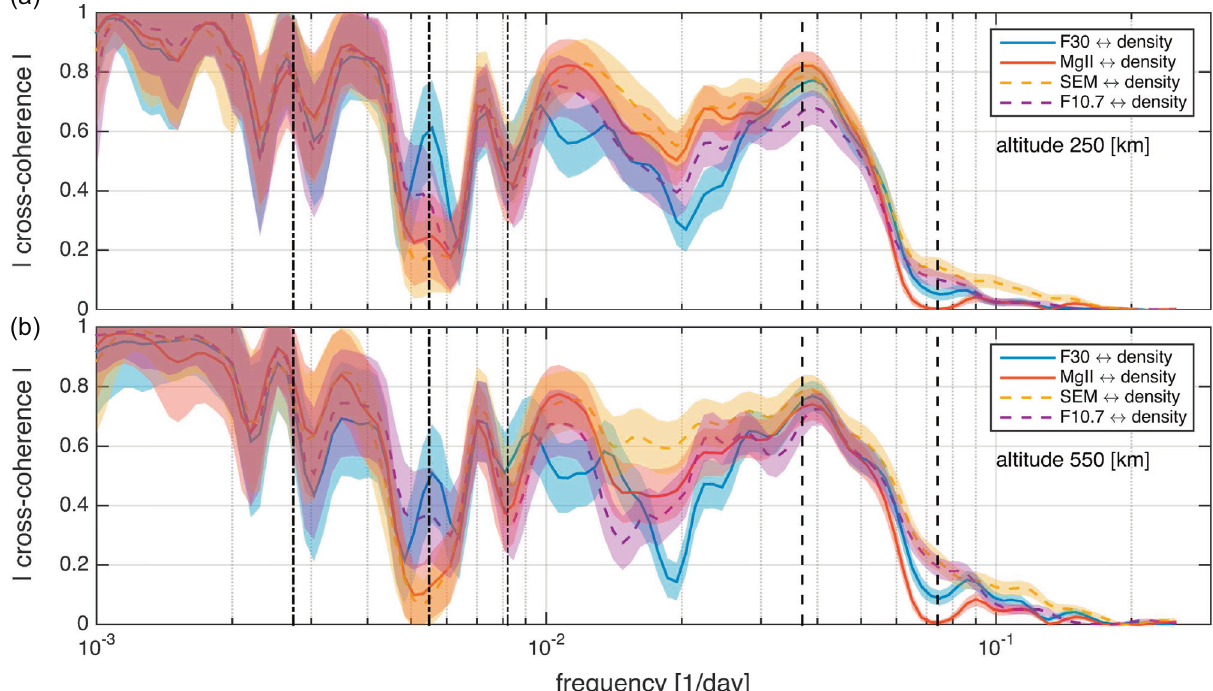
Fig. 6. Modulus of the cross-coherence between three proxies (F30, MgII, SEM and F10.7) and the thermospheric density at 250 km altitude (a), 550 km altitude (b), from 1996 to 2011. Coloured bands correspond to a ± r confidence interval. The 27-day and 13.5-day periods, and periods associated with seasonal variations are indicated by dashed